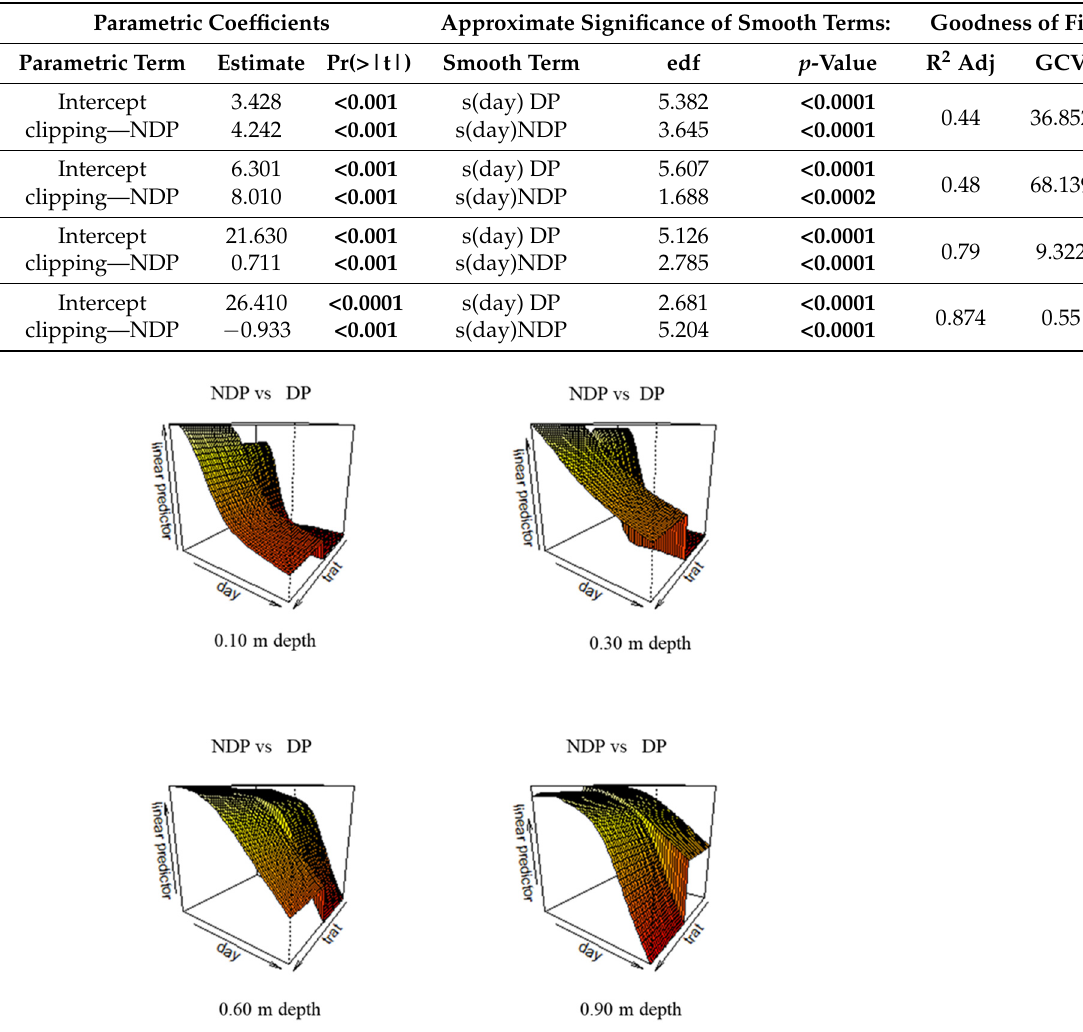
Table 3. GAM models summary statistics, from left to right: depth of the moisture probes, parametric terms, coefficient estimates and relative p -values, smooth terms, effective degrees of freedom (edf), determination coefficient, and generalized cross validation score (GCV).